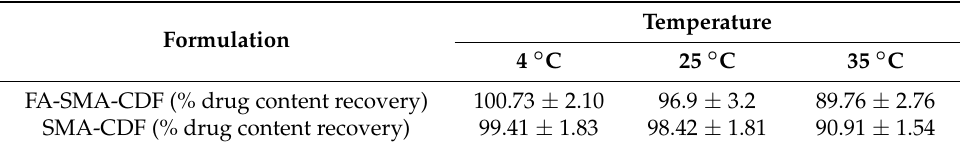
Table 2. Percent drug content of nanomicellar formulations after sixty days ( n = 3). Values expressed as the mean ± standard deviation